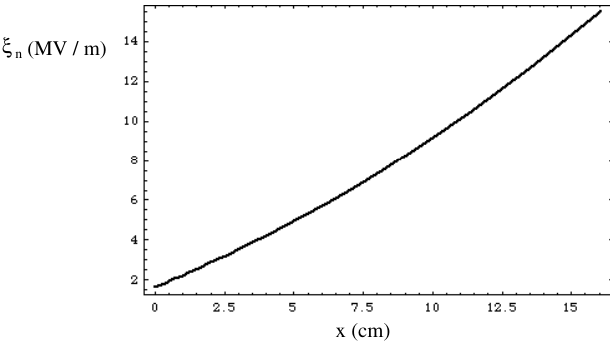
(cid:2) eg(cid:6) (cid:4) sin (cid:3) (cid:8) (cid:4) =(cid:2) FIG. 5. (Color) Average axial field (cid:6) TTF (cid:3) (cid:2) n n n n 0 tion x with (cid:1)